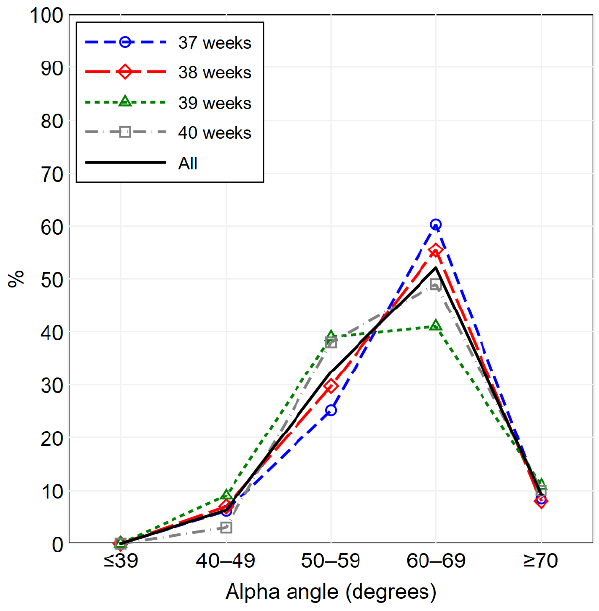
Figure 2. Alpha-angle frequency polygon, overall and by gestational age (37 weeks: n = 131; 38 weeks: n = 101; 39 weeks: n = 100; 40 weeks: n = 100).